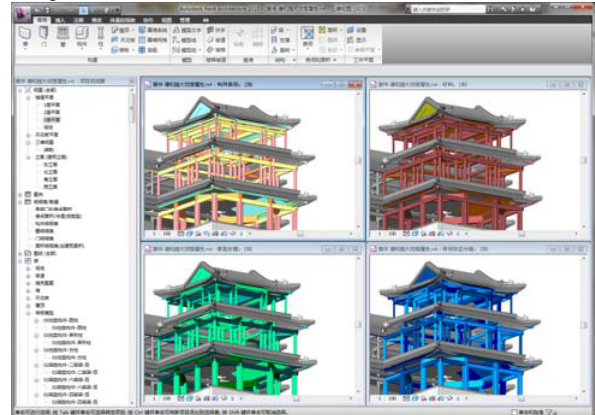
Fig.10. The Build Information Model (BIM) of Opera Tower [ 大戏楼 ] ,